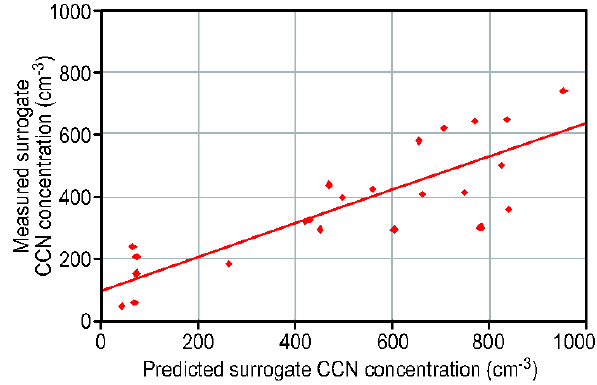
Fig. 11. Comparison via linear regression of the measured surrogate CCN(0.3%) concentration with that predicted by the PMF model for the CARMA III data